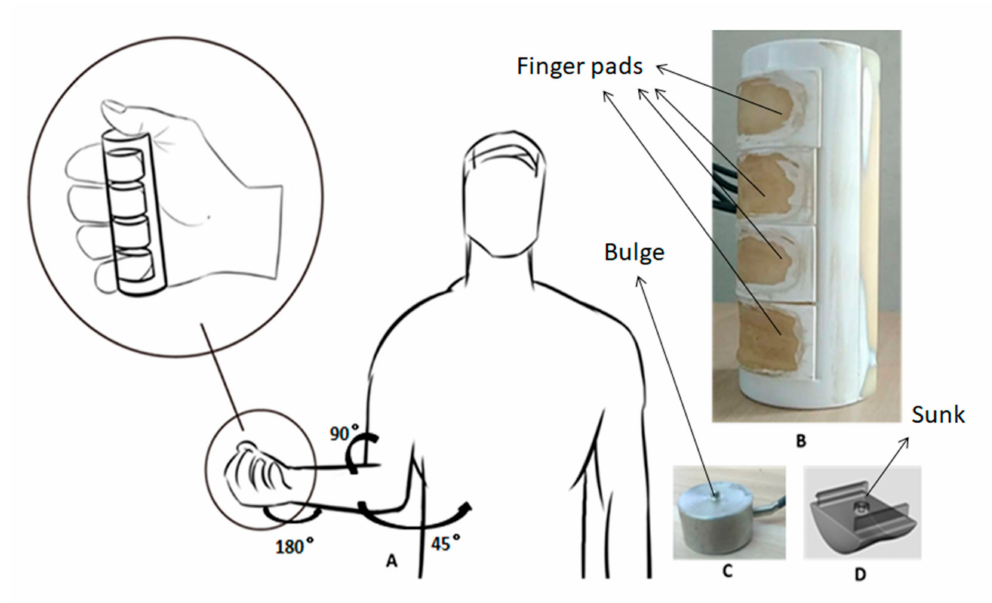
Figure 1. ( A ) shows the posture of the experiment (the enlarged image is top view). ( B ) is the handle used, four-finger pads placed in a row in the handle. ( C ) is the force sensor. ( D ) is the structure of the finger pad. The bulge of the sensor touch the sunk on the back of finger